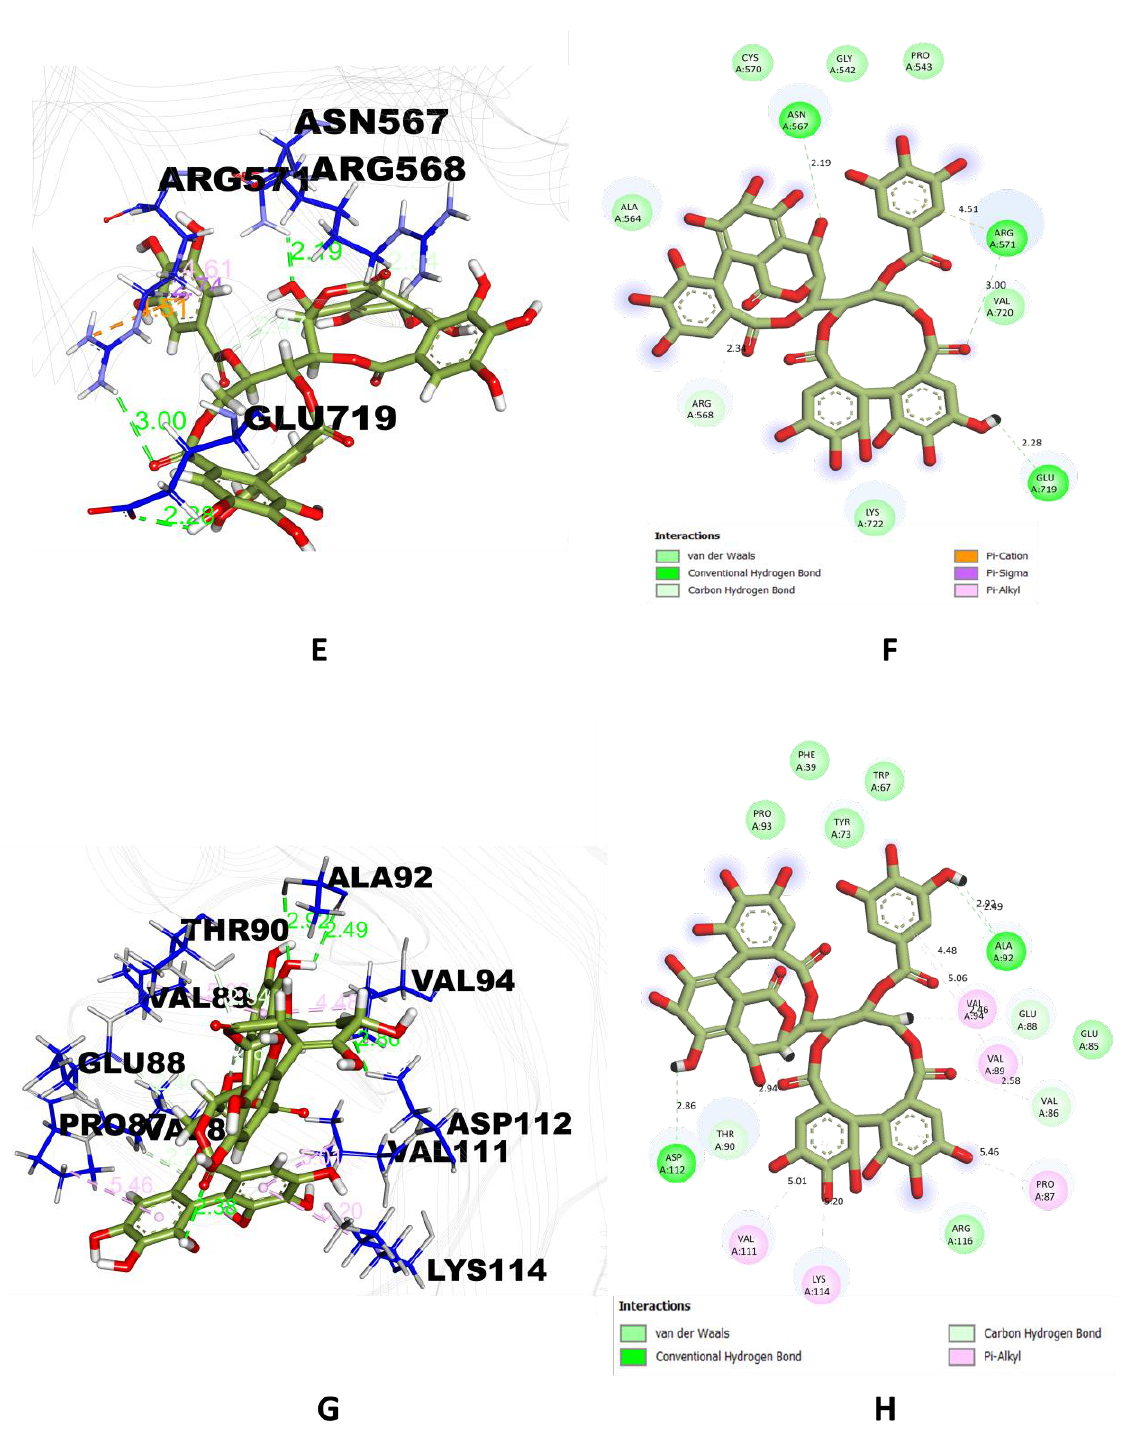
Figure 1. Docked pose of the top-ranked ligand (casuarinin) with target proteins. ( A ) 3-D interactions of casuarinin with interacting amino acids of 4YAY; ( B ) 2-D interactions of casuarinin with interacting amino acids of 4YAY; ( C ) 3-D interactions of casuarinin with interacting amino acids of 4DLI; ( D ) 2-D interactions of casuarinin with interacting amino acids of 4DLI; ( E ) 3-D interactions of casuarinin with interacting amino acids of 1HW9; ( F ) 2-D interactions of casuarinin with interacting amino acids of 1HW9; ( G ) 3-D interactions of casuarinin with interacting amino acids of 1B09 and ( H ) 2-D interactions of casuarinin with interacting amino acids of 1B09.